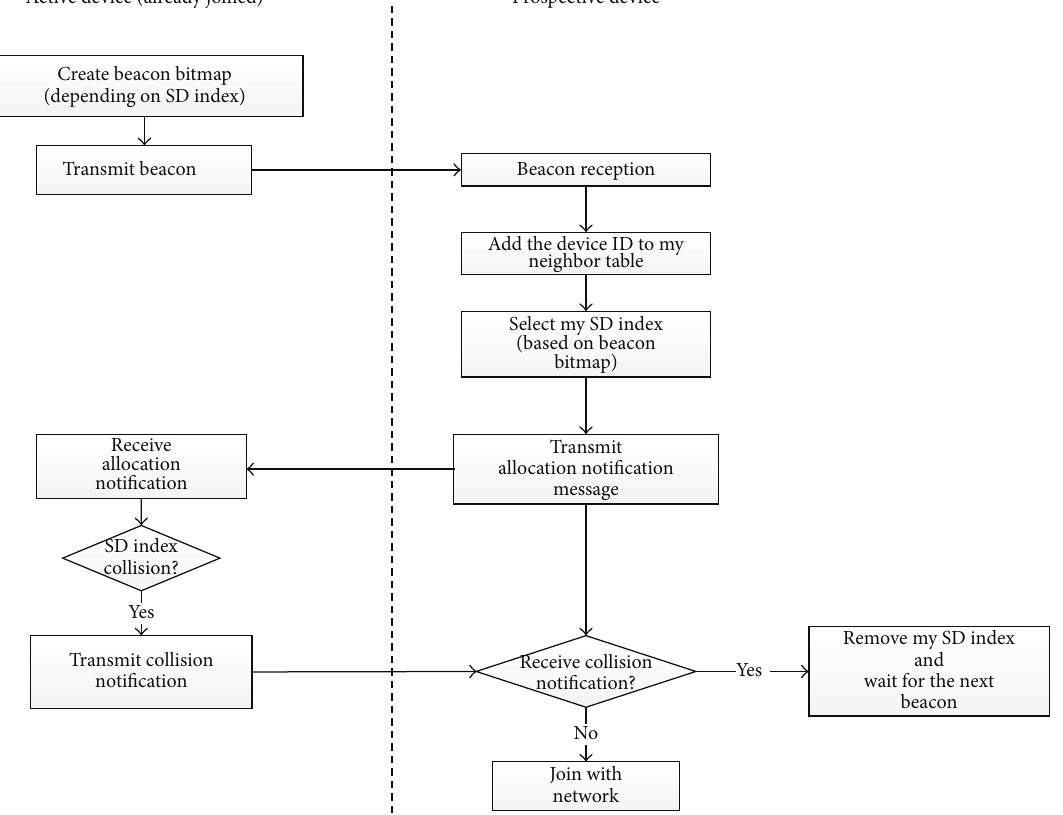
Figure 2: Flowchart of the IEEE 802.15.4e DSME beacon scheduling